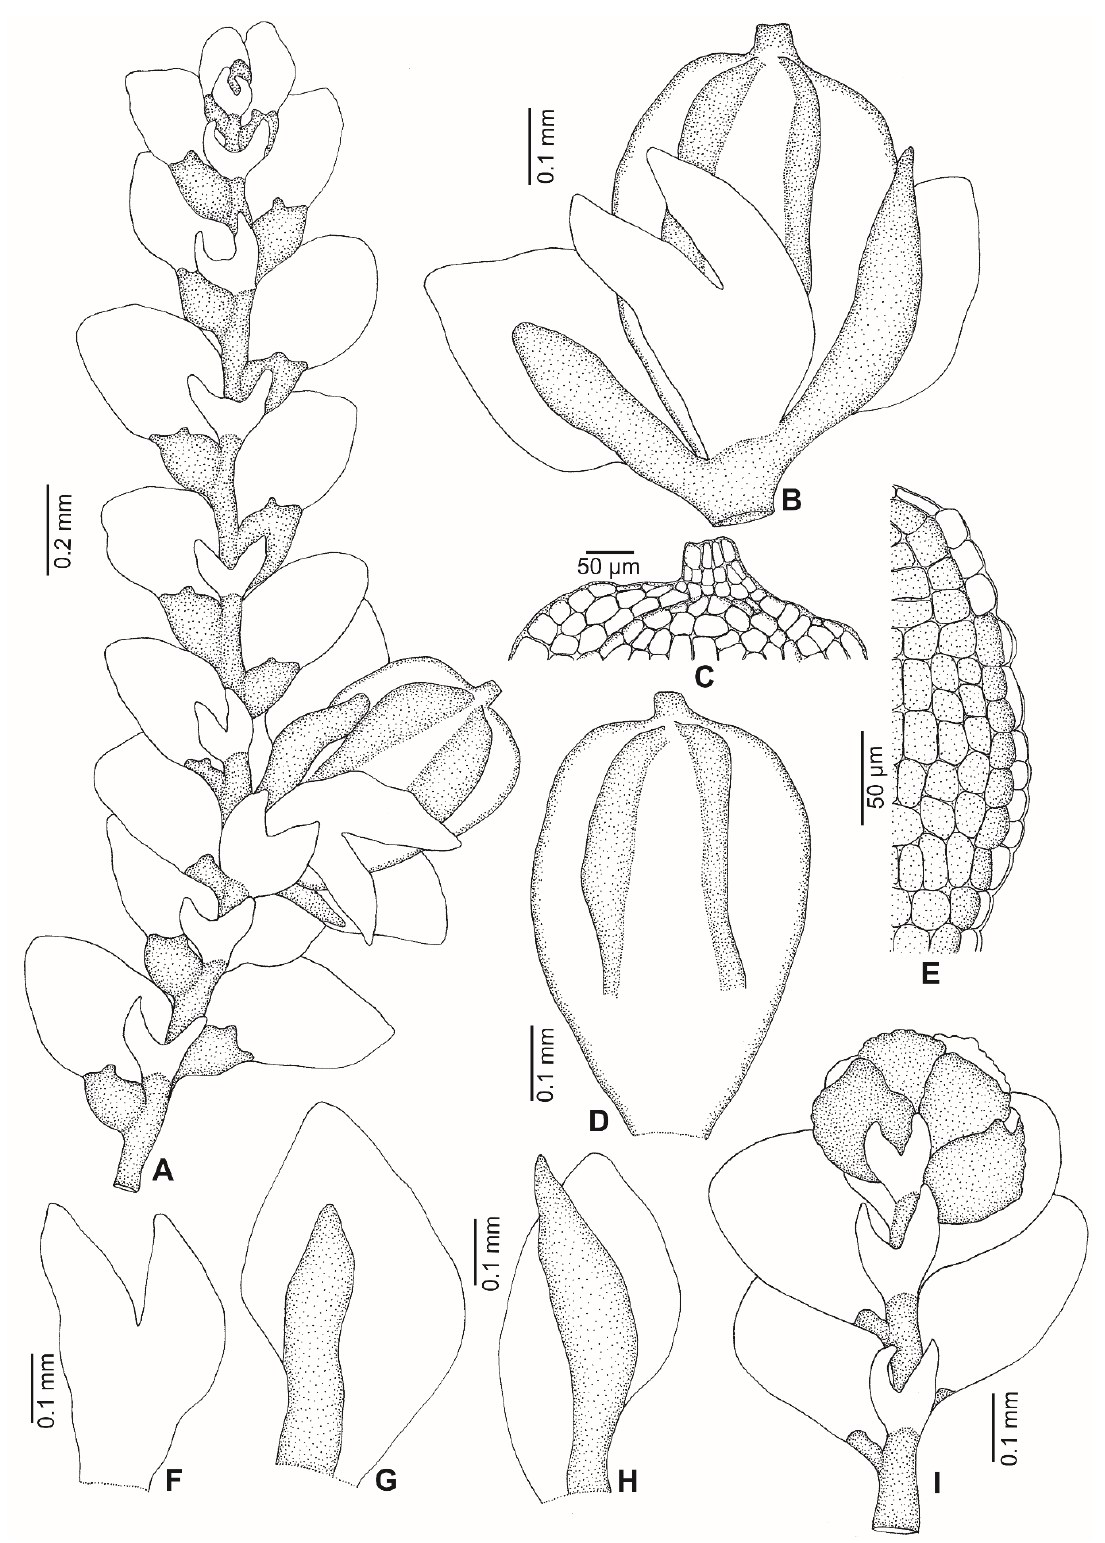
Figure 3. Lejeunea malaysiana G.E. Lee and Pócs, sp. nov . ( A ) Part of plant, with the perianth-bearing branch. ( B ) Perianth with bracts and bracteole. ( C ) Apical cells of the perianth. ( D ) Perianth. ( E ) Cells at the lateral keel of the perianth. ( F ) Female bracteole. ( G , H ) Female bracts. ( I ) Androecial shoot. All were drawn from the holotype , G.E. Lee and H.Y. Tang 11001 (UMTP).